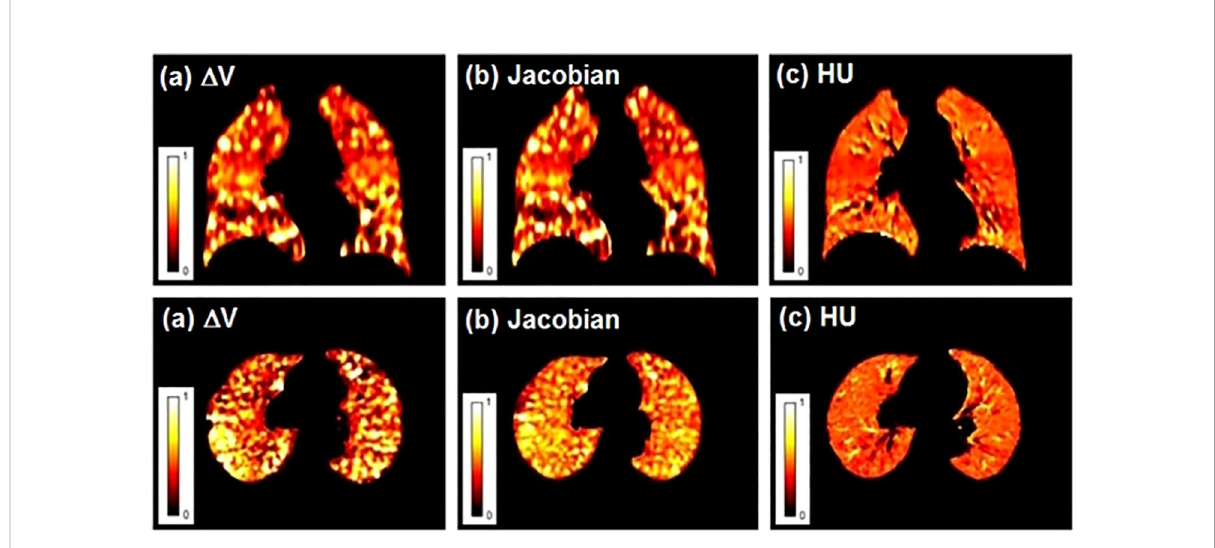
FIGURE 1 Lung ventilation function images obtained by different ventilation imaging algorithms (VIAs). (A) D V; (B) Jacobian; (C) HU. Reproduced from reference (43) with permission from Wiley, copyright